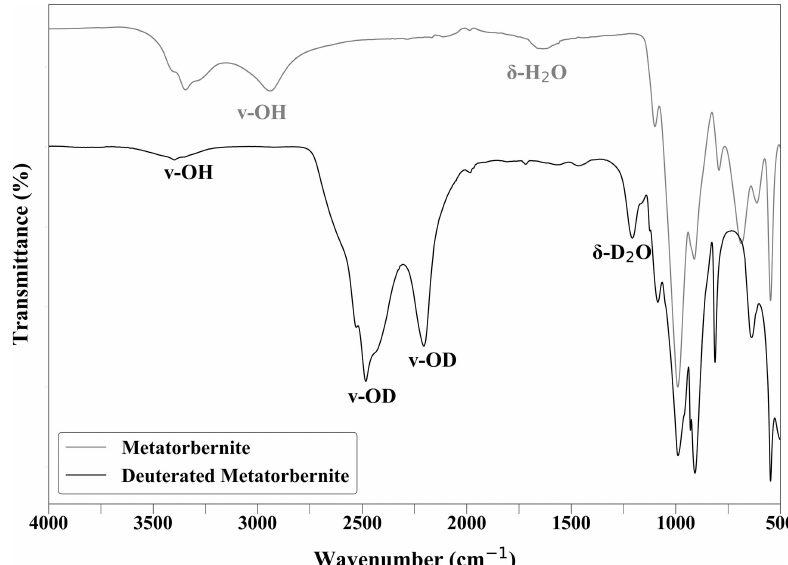
Figure 2 Infrared spectra of metatorbernite pre- and post-deuteration (shown as grey and black, respectively), with labelled (cid:5) -DO and (cid:5) -HO stretching bands and (cid:6) -D 2 O and (cid:6) -H 2 O bending